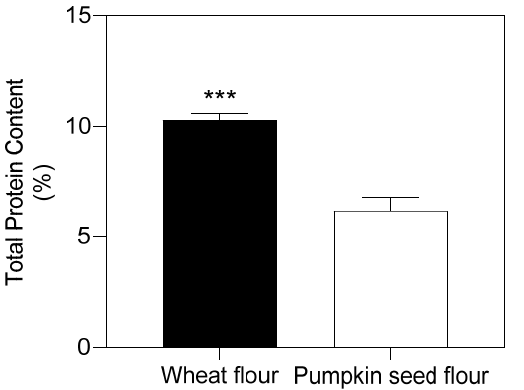
Figure 1. Total protein content (% dry mass) of wheat and pumpkin seed flour. Data were compared with Student’s t -test ( p ≤ 0.05). Significance ***: p ≤ 0.001.